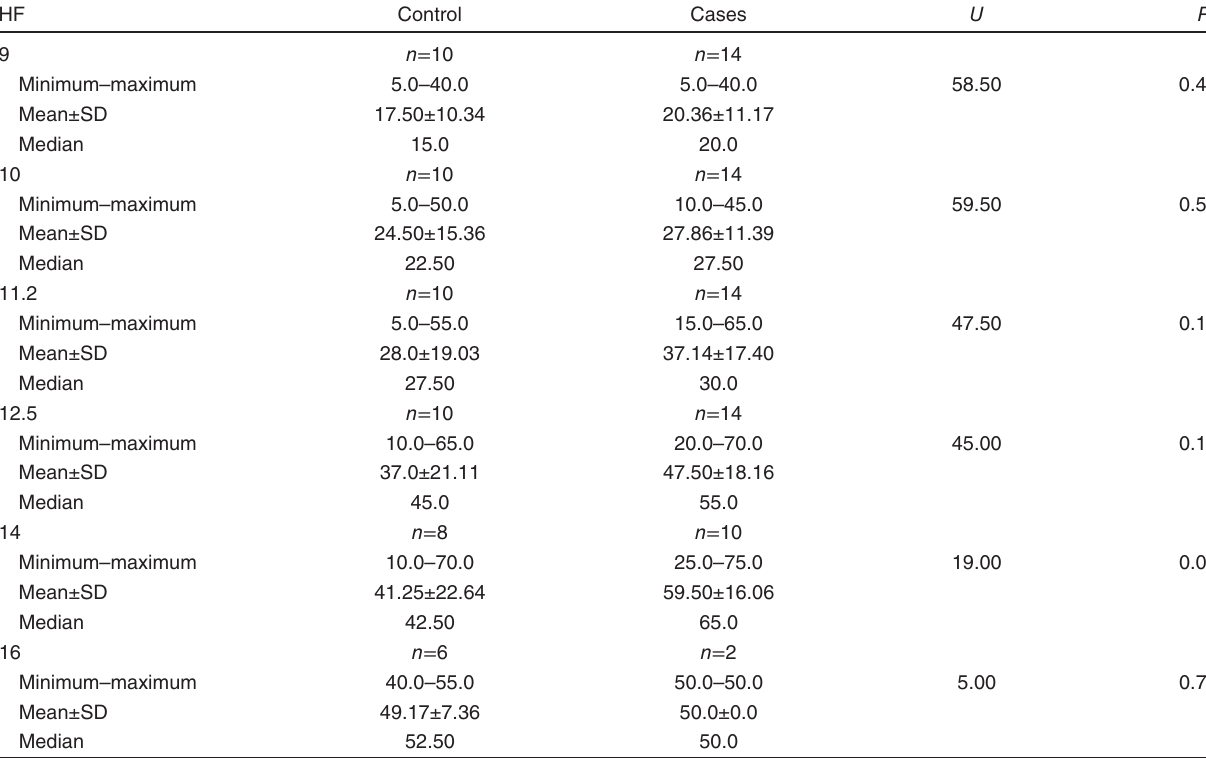
Table 6 High frequency audiometry thresholds in the two studied groups at age from 41 to 50